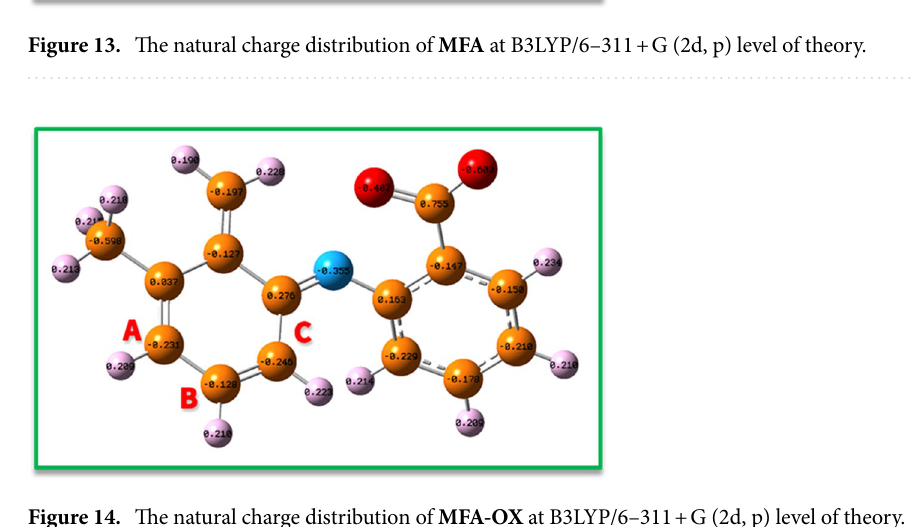
Figure 14. The natural charge distribution of MFA-OX at B3LYP/6–311 + G (2d, p) level of